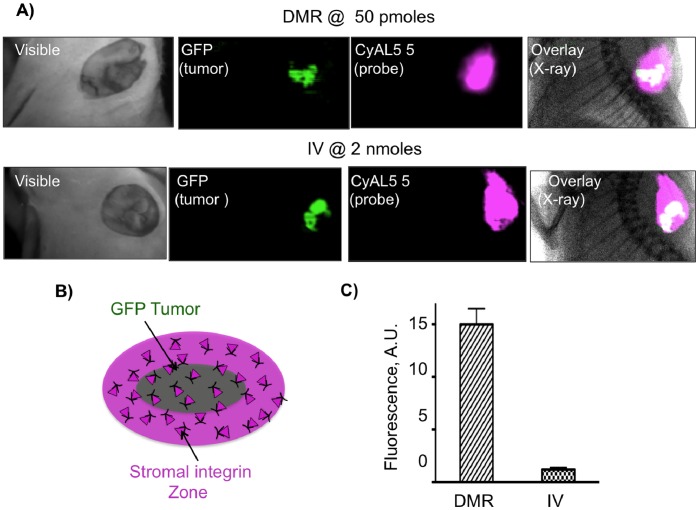
Efficiency of tumor targeting by DMR or IV methods by surface fluorescence.A) Skin covering GFP-BT-20 tumors was removed. Shown are white light images, GFP fluorescence images, probe NIR fluorescence, and the overlay of GFP and probe fluorescence, plus an X-ray image. As with Figure 4, green GFP plus purple NIR fluorescence yields a white overlaid image. B) By with PT DMR or IV, probe fluorescence included a stromal zone of integrin binding surrounding the tumor as was seen in (a). C) A comparison of tumor surface fluorescence intensities by PT DMR versus the IV methods is shown. Doses were 50 pmoles (per site) and 2000 pmoles (IV) for figures 5 and 6.